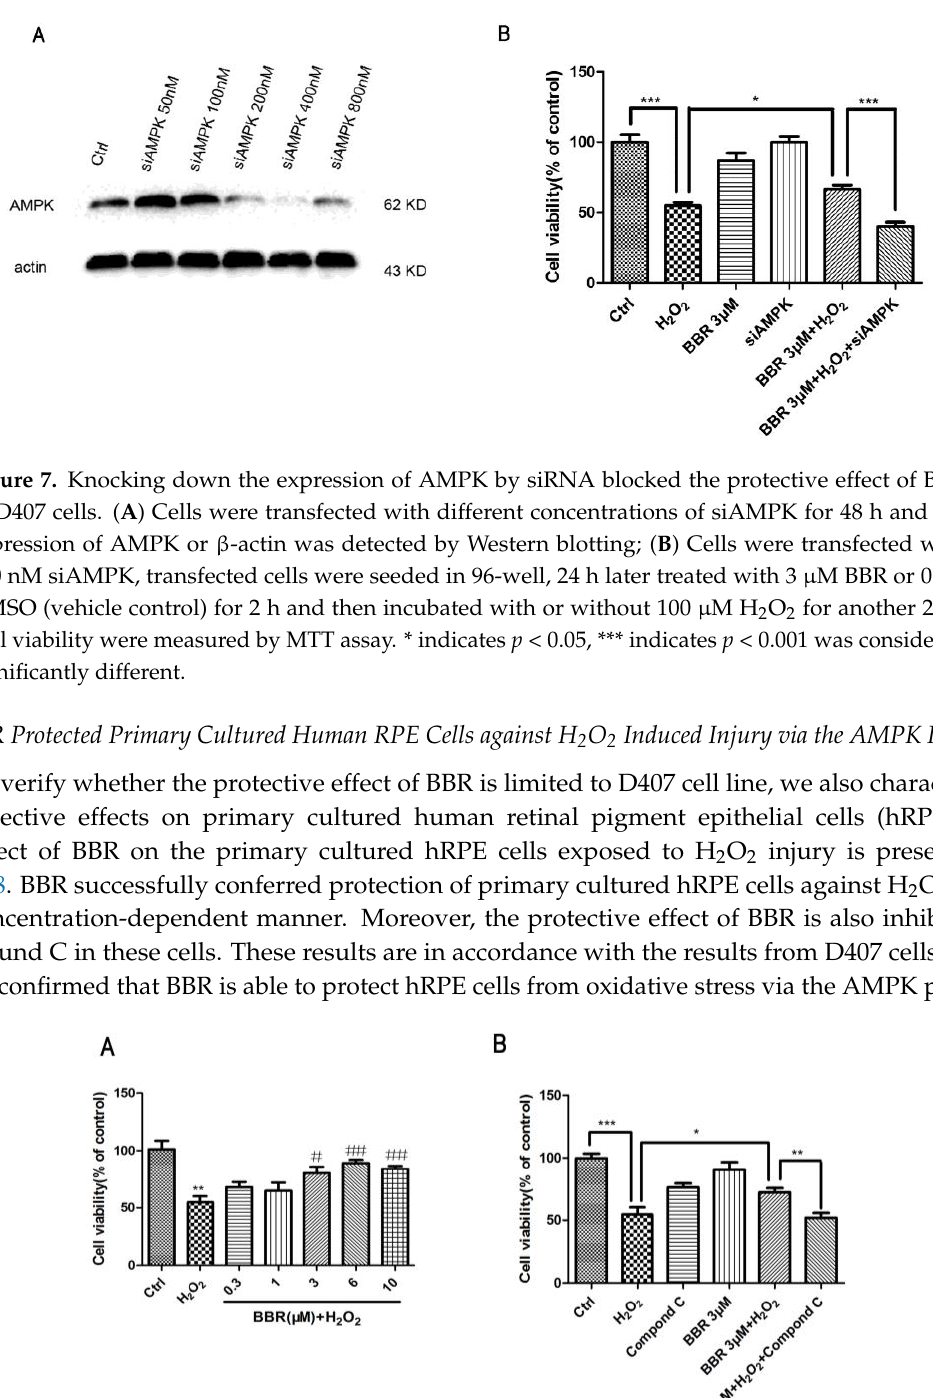
Figure 8. BBR protected primary cultured human RPE cells against H 2 O 2 induced injury via the AMPK pathway. ( A ) Primary cultured hRPE cells were pre-treated with different concentrations of BBR for 2 h, then incubated with or without H 2 O 2 for a further 24 h. Cell viability was measured by MTT assay. ** indicates p < 0.01 versus the control group was considered significantly different, # indicates p < 0.05, ## indicates p < 0.01 versus H 2 O 2 group was considered significantly different; ( B ) Primary cultured hRPE cells were pre-treated with 5 µM Compound C for 30 min and 3 µM BBR for 2 h and then incubated with or without H 2 O 2 for further 24 h, and cell viability was measured using the MTT assay. * indicates p < 0.05, ** indicates p < 0.01, *** indicates p < 0.001 was considered significantly different.